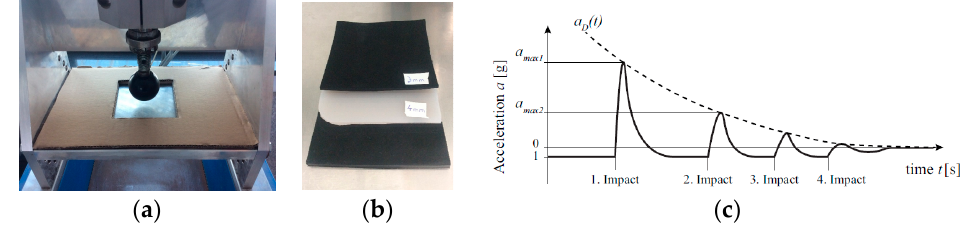
Figure 1. ( a ) Impactor machine; ( b ) three samples in the size 100 cm 2 ; ( c ) the example